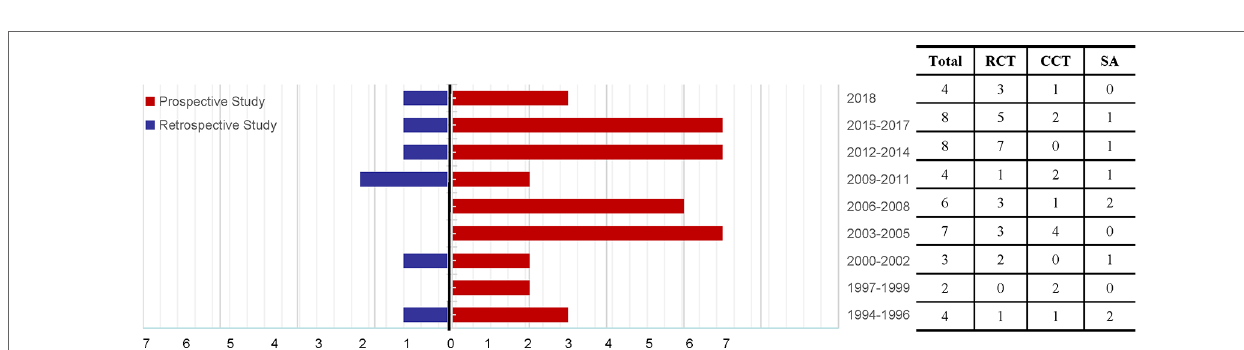
FIGURE 2 | Pie chart for the diagnosis of diseases treated with Tripterygium wilfordii tgpolyglycoside.